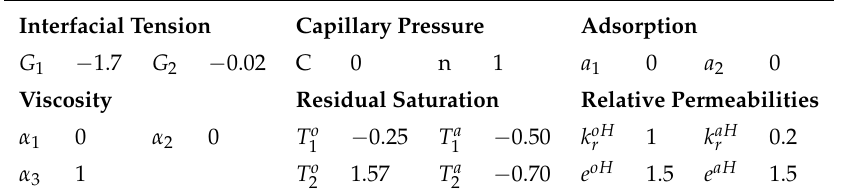
Table 4. Auxiliary parameters.